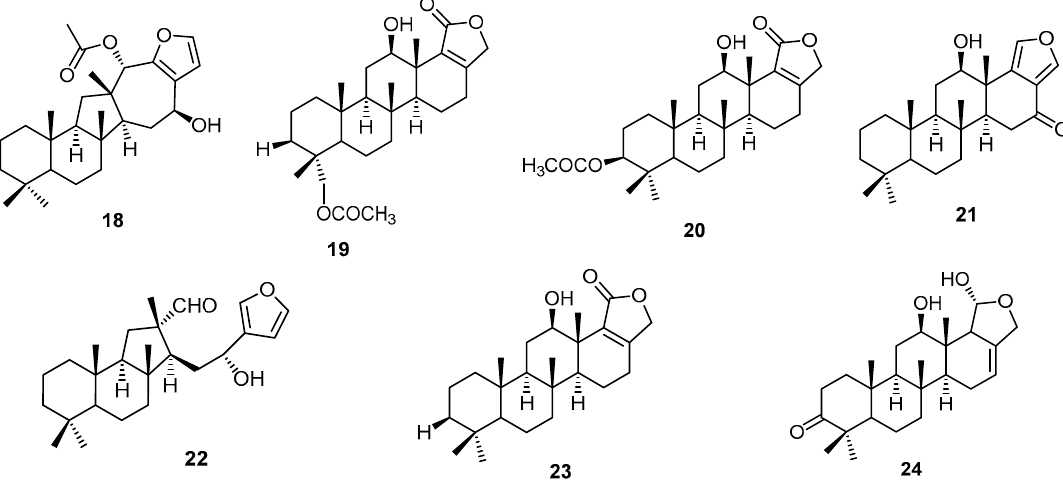
Figure 6. Chemical structures of salmahyrtisol A ( 18 ), 3-acetyl sesterstatin ( 19 ), 19-acetyl sesterstatin 3 ( 20 ), salmahyrtisol B ( 21 ), hyrtiosal ( 22 ), scalarolide ( 23 ) and salmahyrtisol C ( 24 ).